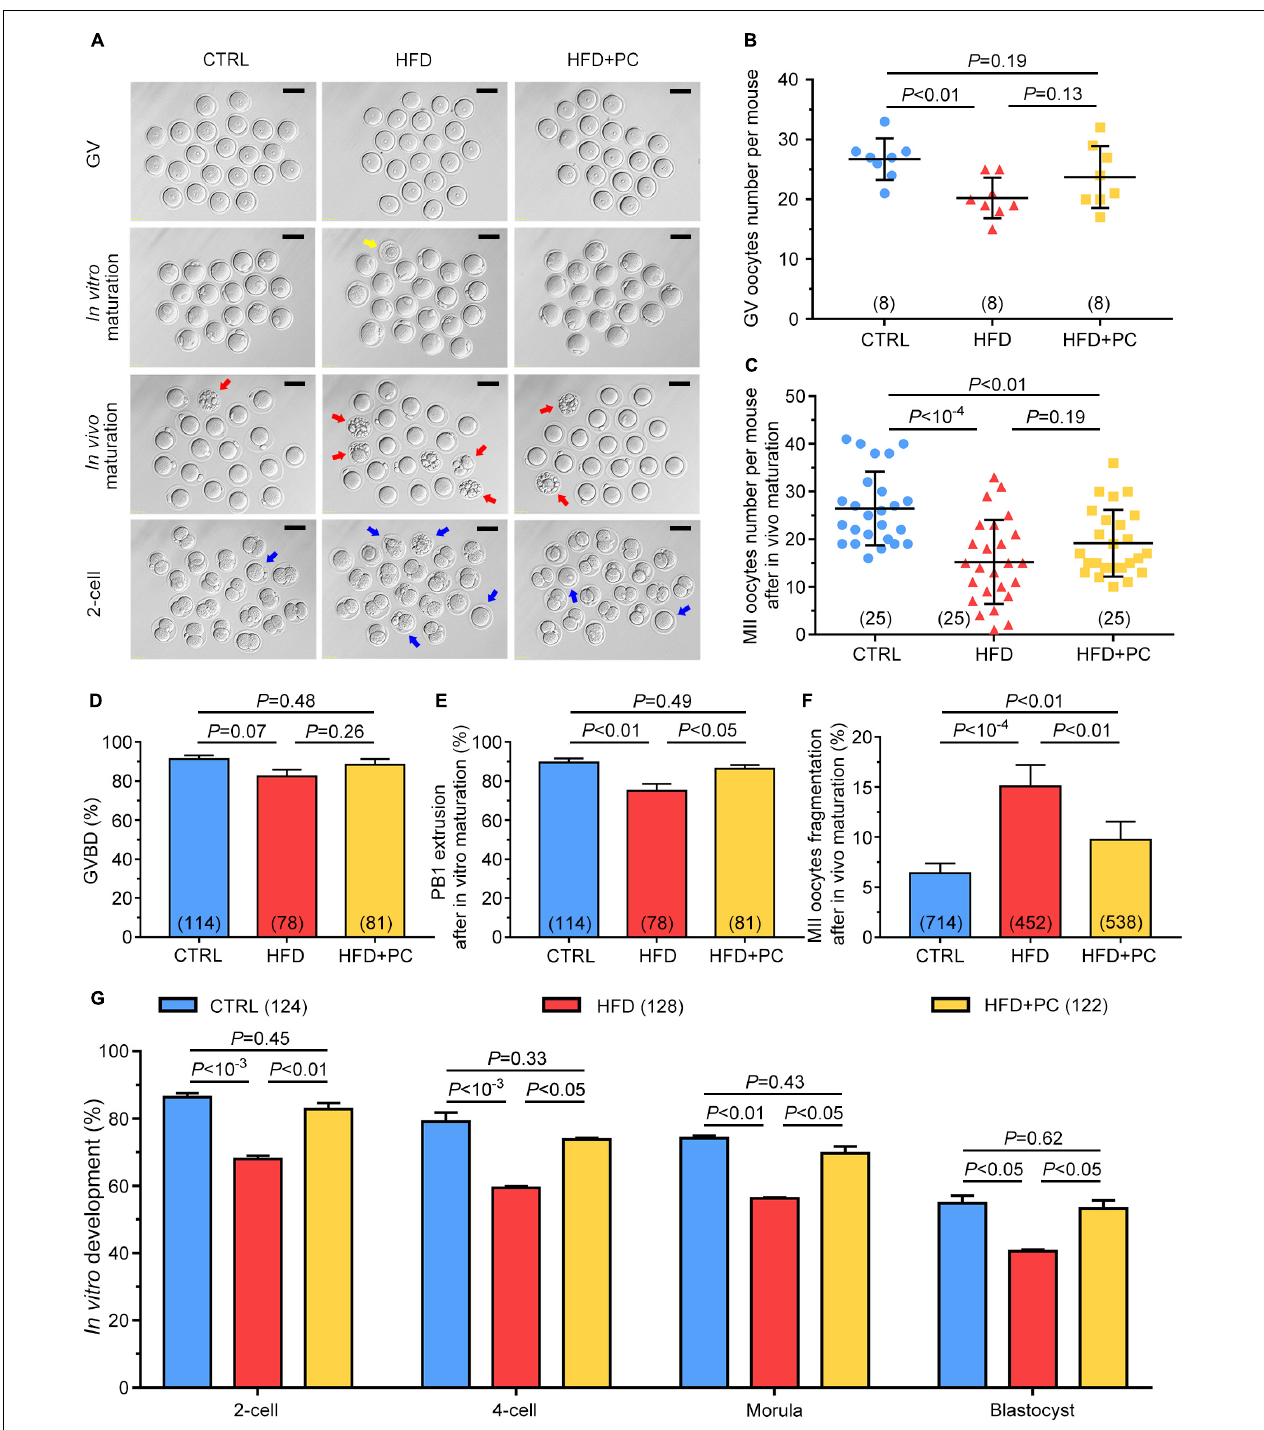
FIGURE 4 | PC rescued oocyte quality in obese mice. (A) Representative morphological images of GV, in vivo or in vitro matured oocytes, and 2-cell stage embryos. The yellow arrow indicates an oocyte with degenerated cytoplasm, red arrows indicate fragmented oocytes, and blue arrows indicate oocytes with failed fertilization or cleavage. Scale bar = 100 µ m. (B) Number of GV oocytes per mouse. (C) Number of MII oocytes per mice after in vivo maturation. (D) The percentage of oocytes that underwent GVBD. (E) The percentage of in vitro cultured GV oocytes that underwent PB1 extrusion. (F) The percentage of oocytes with fragmentation morphologies. (G) The percentage development to 2-cell, 4-cell, morula, and blastocyst embryos. Data are expressed as mean ± SD and were compared by one-way ANOVA and Newman–Keuls post hoc tests. The number of mice assessed in each group is indicated in parentheses for (B,C) . The number of oocytes or embryos assessed in each group is indicated in parentheses for (D–G)